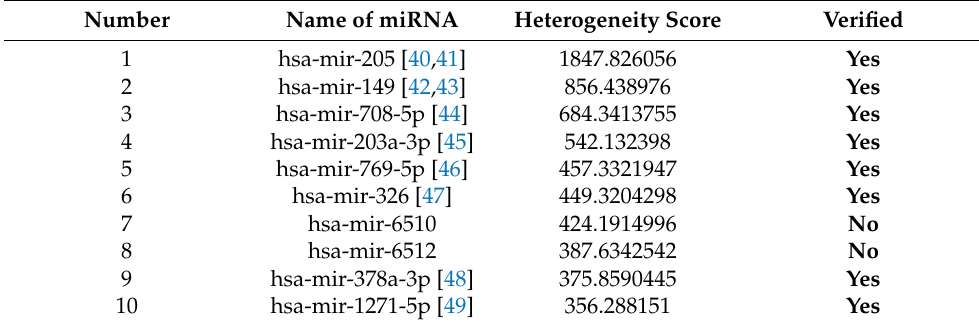
Table 7. The detail of the top 10 miRNA in our